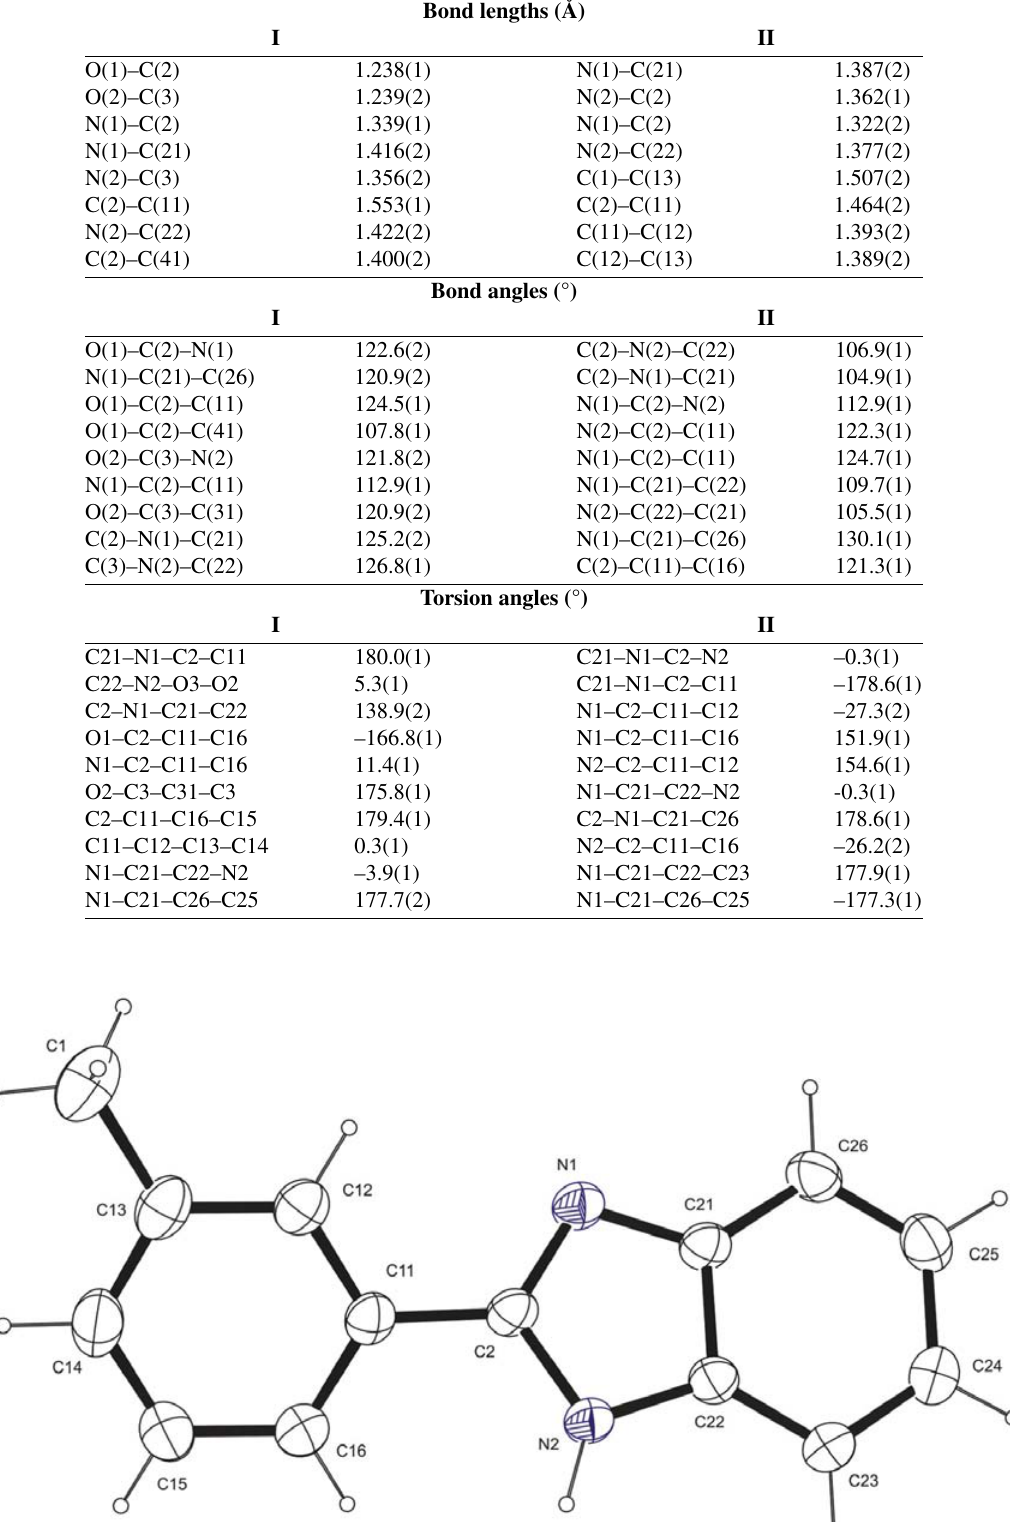
Table 2 Selected bond lengths (Å), bond angles (°) and torsion angles (°) of compounds I and II